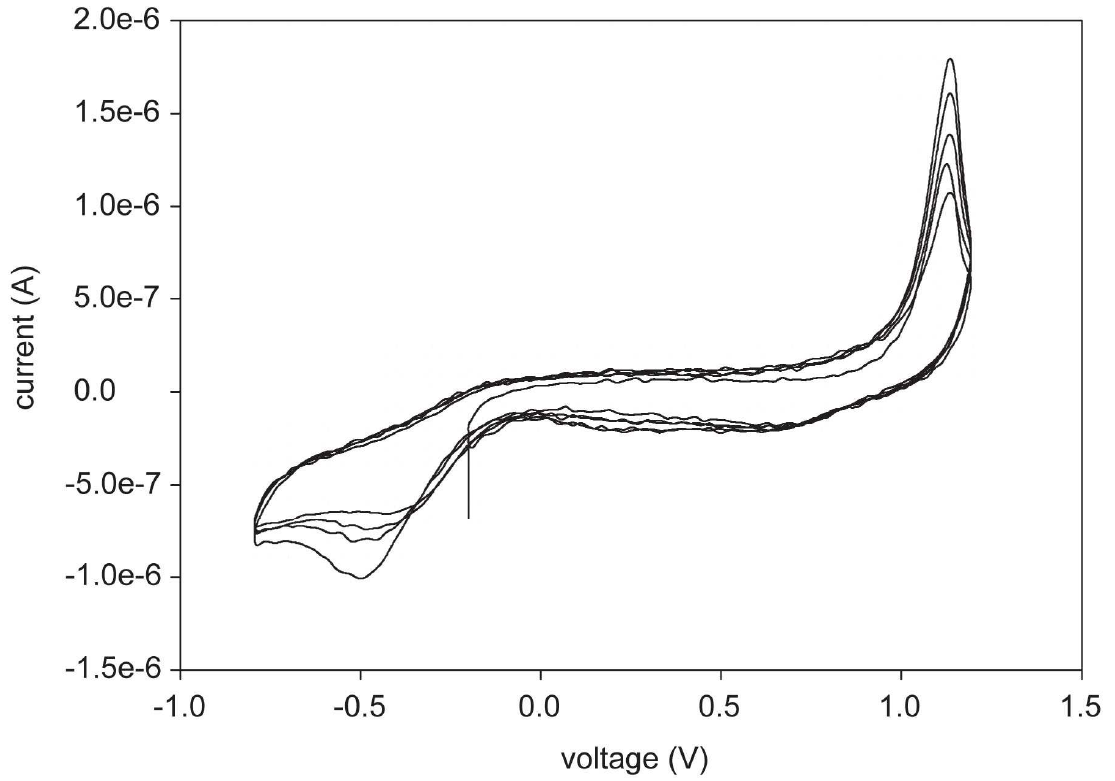
Figure 3. The result of the cyclic voltammetry of the electrode array. The slew rate was 25mV/s and the voltage sweep was from -0.8V to 1.2V in the first 5